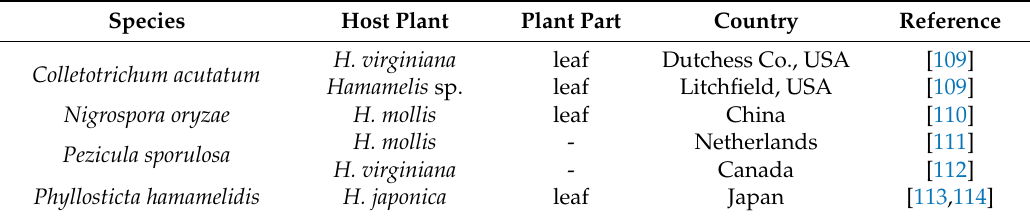
Table 9. Endophytic fungi isolated from Hamamelis